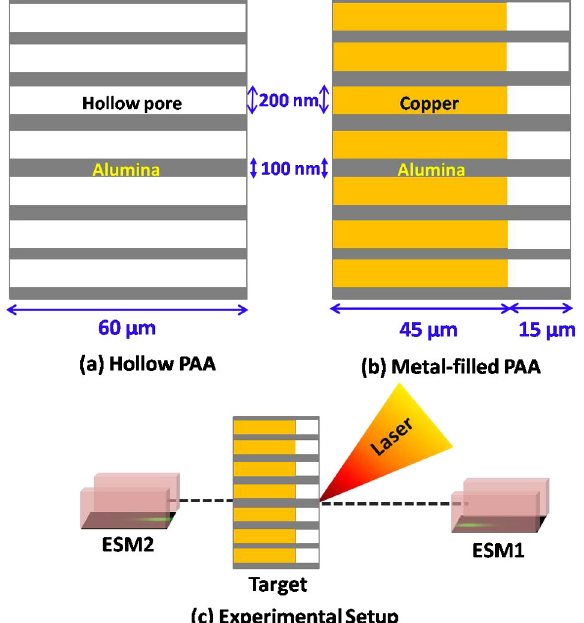
FIG. 1. Schematic representation of a nanochannel target: (a) hollow PAA and (b) metal-filled PAA (hybrid target). The hybrid target is partly filled with 45 (cid:1) m long Cu nanorods. The laser incidence direction is from right to left for both targets. The sketch of experimental setup with the ESM is shown in